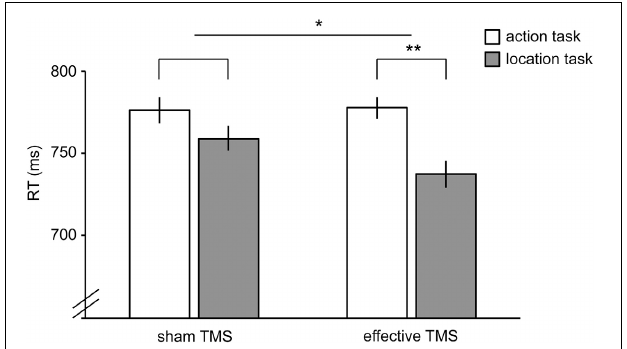
FIGURE 5 | Results of TMS experiment. Reaction times in the action task (white bars) and location task (gray bars) during sham TMS (bars on the left) and effective TMS (bars on the right) applied over hand-/tool-selective left LOTC. TMS differentially affected the two tasks, as indicated by a significant TMS x Task interaction. Error bars reflect within-subject s.e.m. ∗ P < 0 . 05; ∗∗ P < 0 . 005.